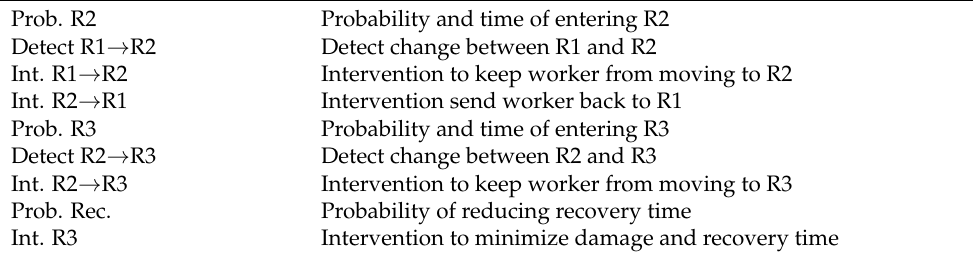
Table 3. REDECA components and shorthand notations used in industry Tables